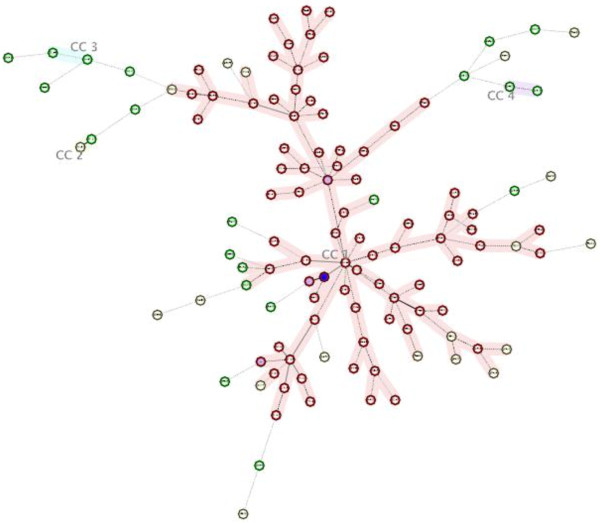
Minimum Spanning Tree. This tree was generated with 15 MIRU-VNTR loci of the 123 strains from Jiangxi Province, China, using the MIRU-VNTRplus database (http://www.miru-vntrplus.org). CC1, CC2, CC3, and CC4 represent four major clonal complexes. The maximum locus difference within a clonal complex is five. The red circle denotes the Beijing family strain, while the blue circle denotes the non-Beijing family strain.